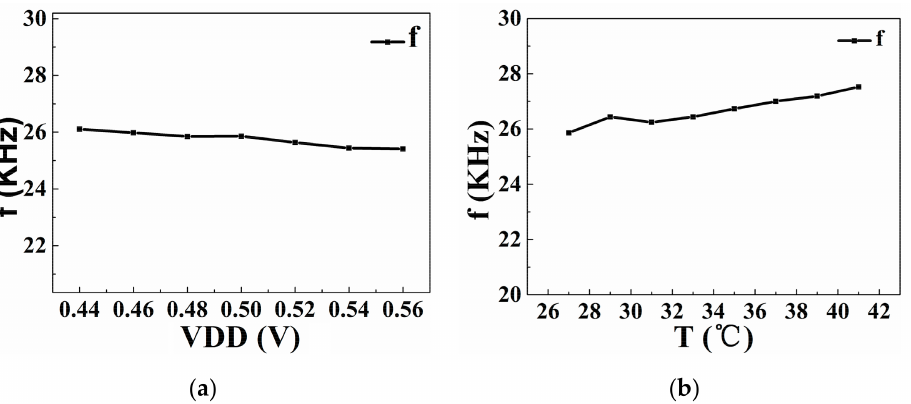
Figure 11. The influence of the supply voltage and the temperature on the transmitting frequency. ( a ) The variation of the firing frequency with the supply voltage. ( b ) The variation of the firing frequency with the